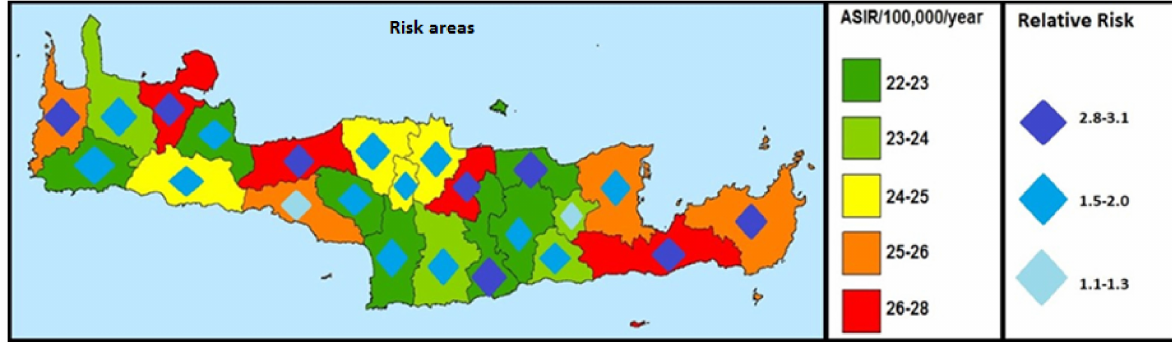
Figure 5. Risk areas of low survival of patients with malignant liver tumor according to the identified risk factors. (All RRs are statistically significant, p -value <